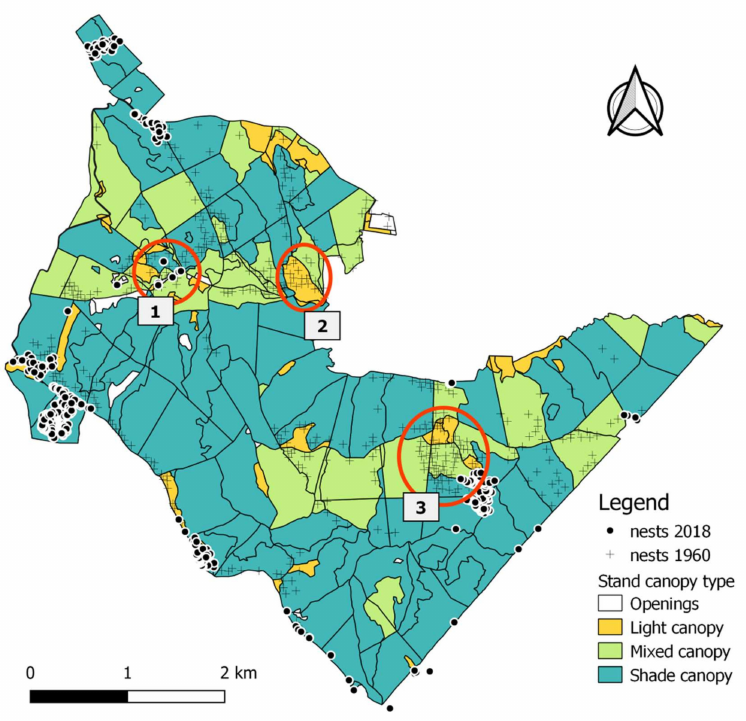
Figure 4. Distribution of RWA in 2018 (n = 512) and canopy classification. Red circles refer to areas where unexpected changes in RWA settlement occurred (for details see Section 4.5).